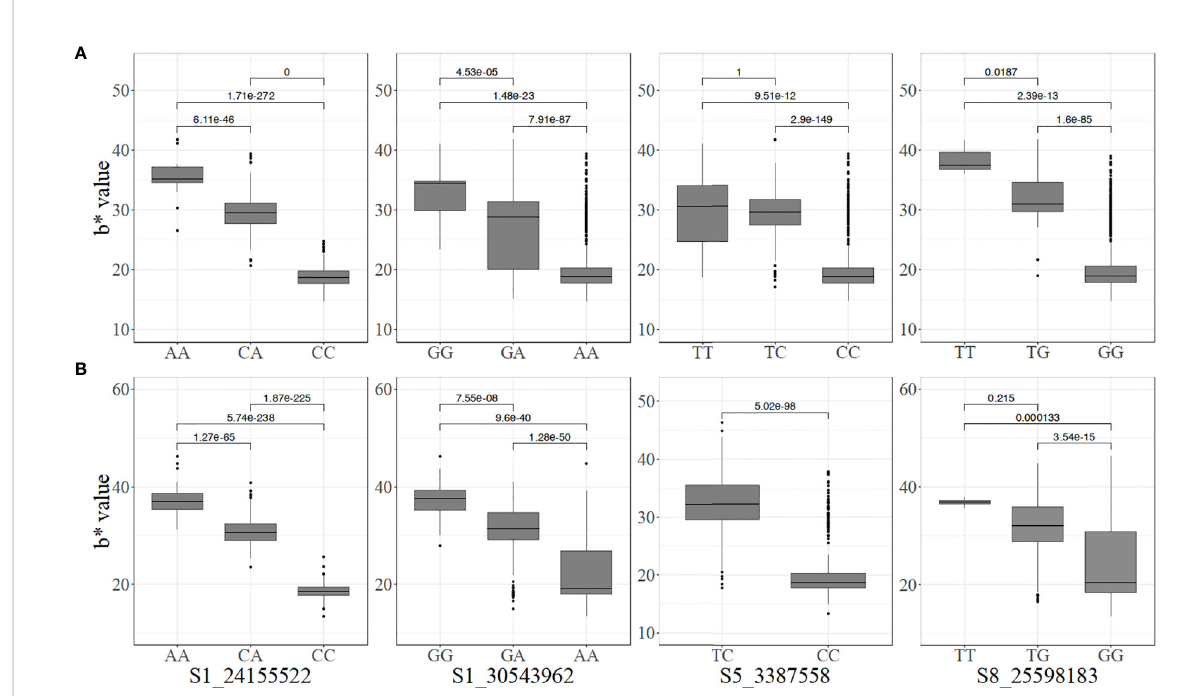
FIGURE 3 Allelic substitution effects of the markers associated with increased carotenoid content in the (A) breeding, and (B) pre-breeding populations (For marker S5_3387558, the mean and standard deviation cannot be estimated because one genotype had